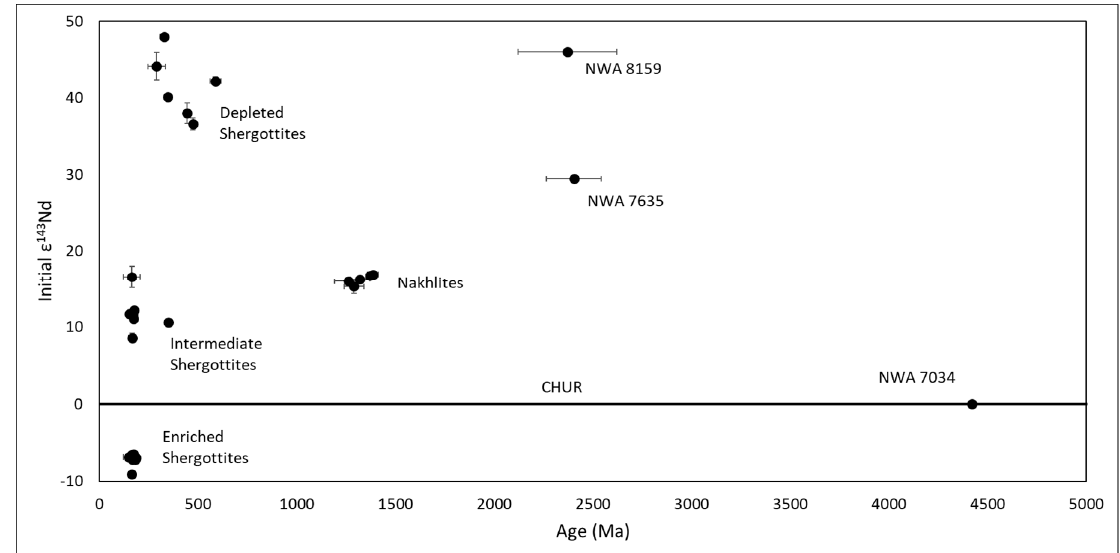
Figure 2. 147 Sm / 143 Nd ages and calculated initial ε Nd values for Martian meteorites [11,12,35–40,43– 54,55,65–68,71,76,77].